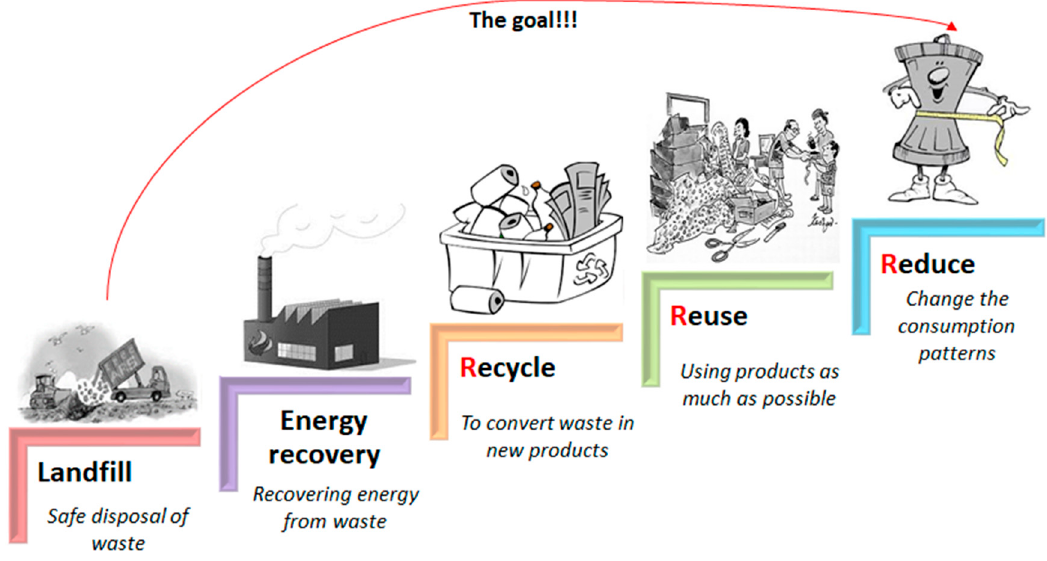
Figure 1. Hierarchy for waste management strategy.